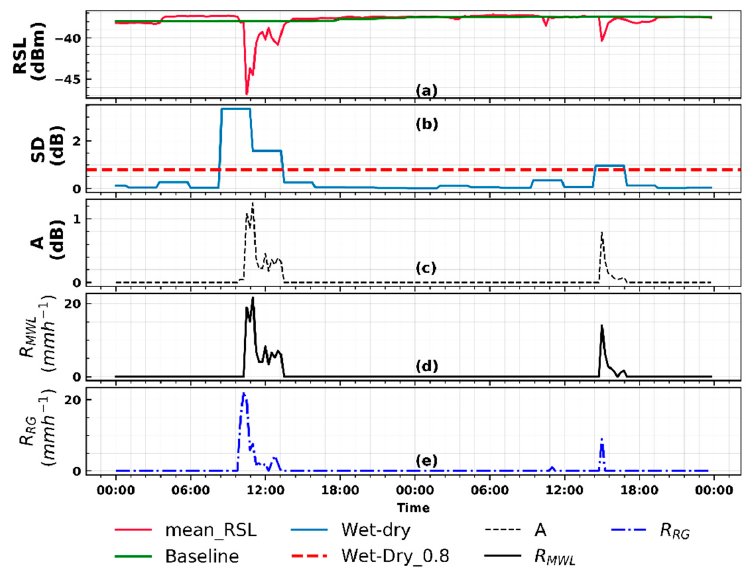
Figure 2. From raw RSL to rainfall using MWL data from Kericho, on 11 May 2013 to 12 May 2013. ( a ) mean and reference RSL ( b ) rolling standard deviation with a threshold of 0.8 dB for detecting wet/dry periods ( c ) attenuation ( d ) MWL derived rainfall intensities, and ( e ) rain gauge derived rainfall intensities.